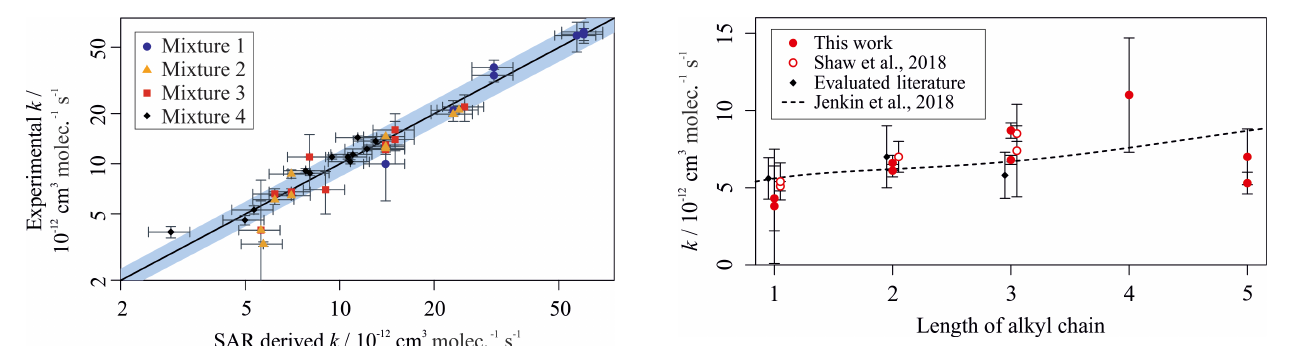
Figure 5. Measured VOC + OH rate coefficients plotted against SAR-derived rate coefficients for all compounds in Mixtures 1, 2, 3, and 4. The grey shaded area demonstrates a 25% uncer- tainty in the 1:1 black gradient line. Most data fall well within this bound. The structure–activity relationships used can be found in Jenkin et al. (2018a, b). Outliers are 2,2,3-trimethylbenzene, toluene, t -butylbenzene, n -butylbenzene, n -pentylbenzene, and o - xylene. Most outliers have large derived uncertainties in their mea- sured value.